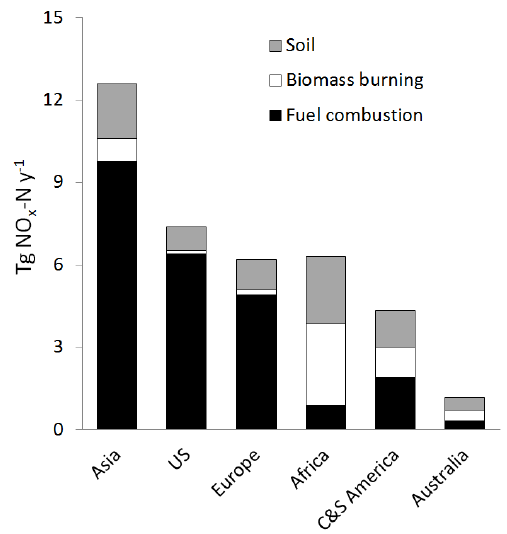
Figure 6. Spatial distribution of NO x emissions for the year 2000 from the main sources: fossil and biofuel combustion, biomass burning and soils and main region. Data are the a posterior data (top down and bottom-up NO x emission inventory from Jaeglé et al., 2005).